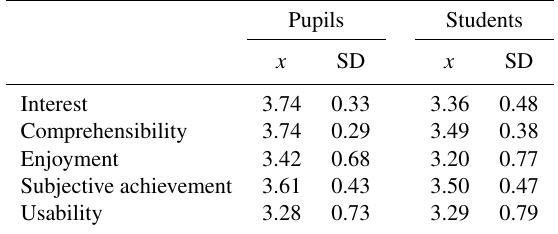
Table 4. Results of the formative evaluation (Likert-scale from 1 = strongly disagree to 4 = strongly agree).